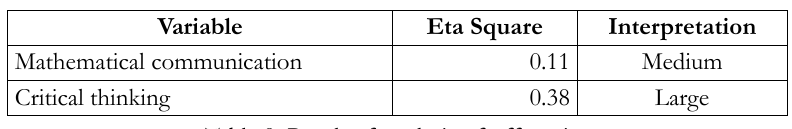
Table 9. Result of analysis of effect size